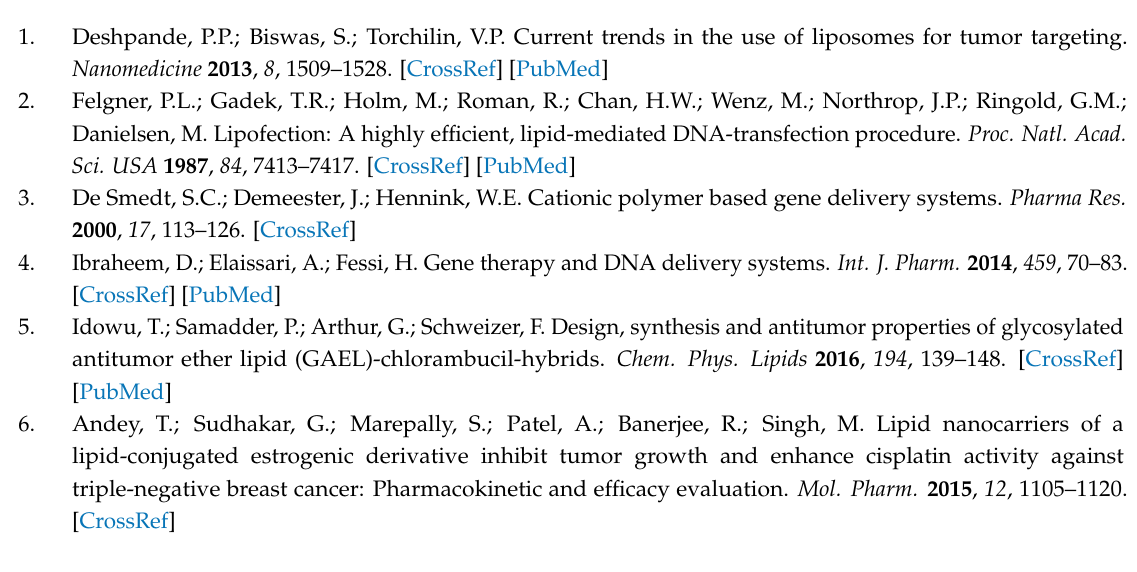
Table S1: Toxicity test data of tested 4-( N -alkylpyridinium)-1,4-DHPs 3 , 6 , 7 , and 9 – 11 on microorganism species; Figure S1: Representative example of determination of critical aggregation concentration (CAC) by DLS technique for 4-( N -hexadecylpyridinium)-1,4-DHP derivative 11 . Author Contributions: A.P. and A.S. conceived and designed the experiments; M.R., K.P. (Klavs Pajuste) and M.P. performed the re-synthesis of compounds; P.D., O.P. and K.P. (Karlis Pajuste) performed experiments by DLS; A.G., L.J. and I.D. performed the estimation of LD 50 from IC 50 values; S.K. and J.L. performed the toxicity tests on microorganisms; K.P. (Klavs Pajuste), P.D. and K.P. (Karlis Pajuste) performed the determination of CAC; P.D. performed the phospholipid binding assay; K.S. registered the TEM images; K.P. (Karlis Pajuste), P.D., M.P., D.T., J.L., I.D. and A.P. analysed the data; D.T. and A.S. contributed reagents/materials tools; and A.P. and A.S. wrote the